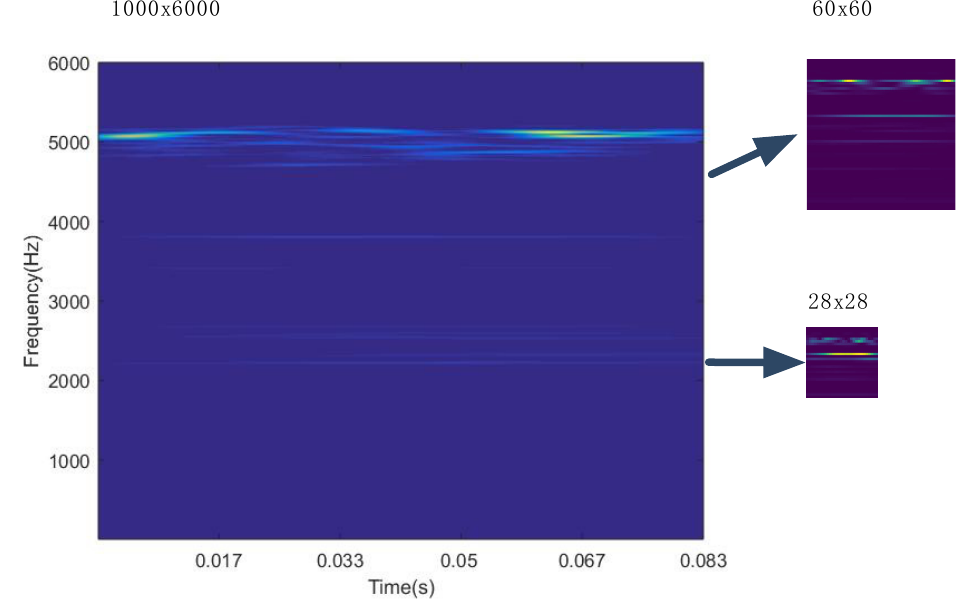
Figure 5. Resized image based on bilinear interpolation.